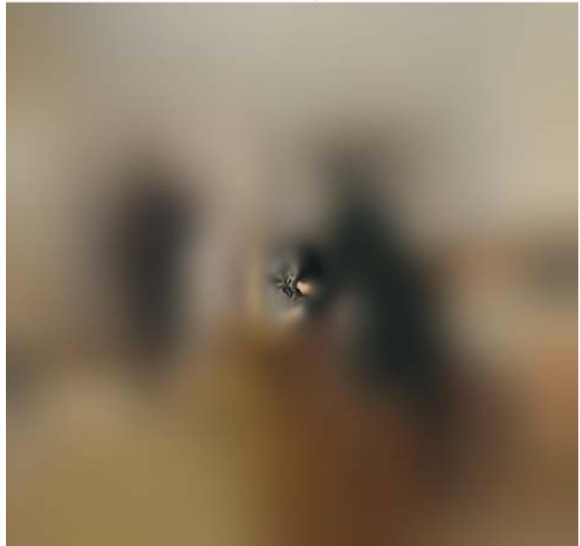
Figure A.2. Foveated image obtained using the algorithm in Geisler and Perry with modifications that make resolu- tion fall-off more smoothly toward the periphery.